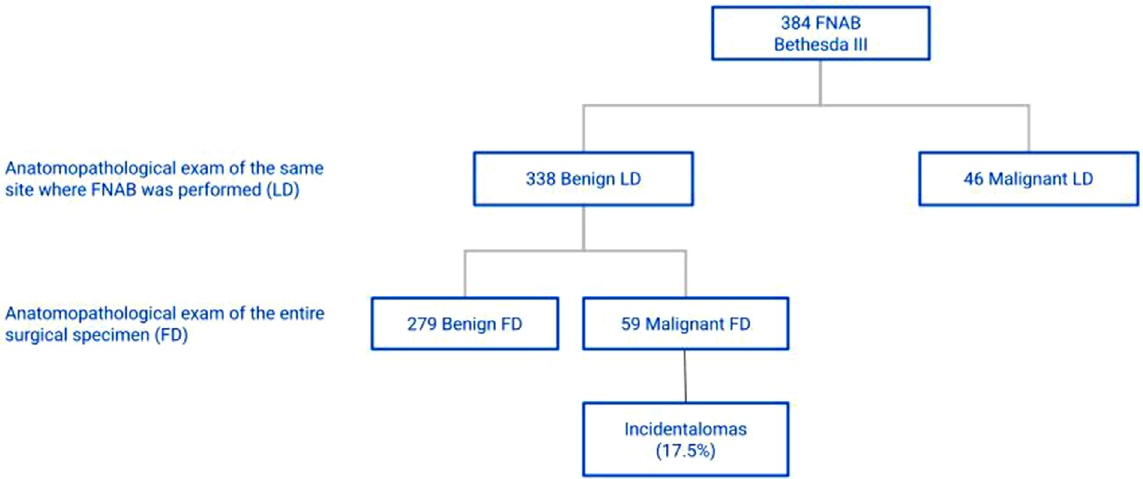
Fig. 2. Anatomopathological exams of patients categorized as Bethesda